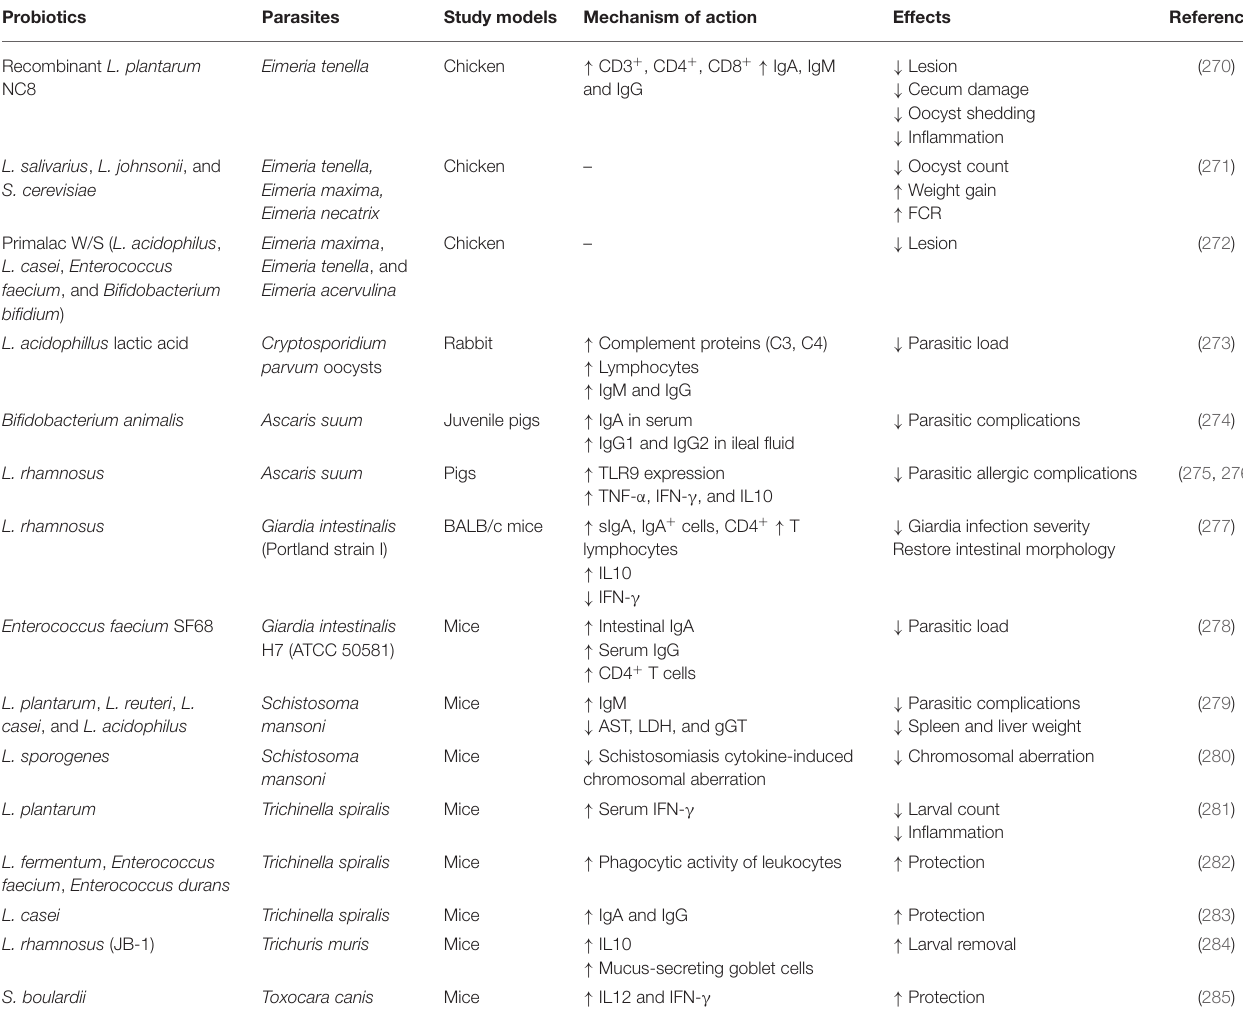
TABLE 4 | Probiotics therapies during parasitic